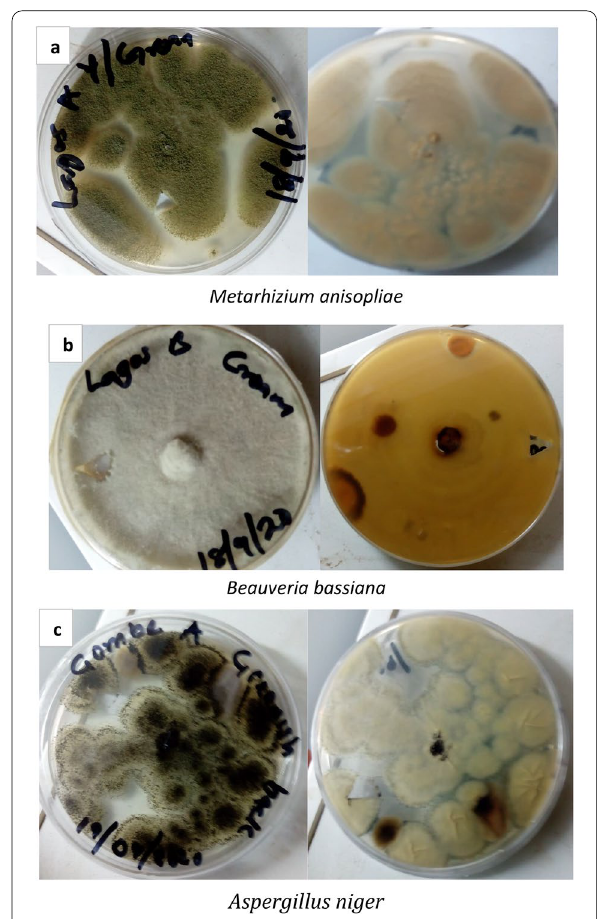
Fig. 1 Front and reverse photograph of some entomopathogenic fungal colonies on PDA with, A Metarhizium anisopliae, B Beauveria bassiana , C Aspergillus niger